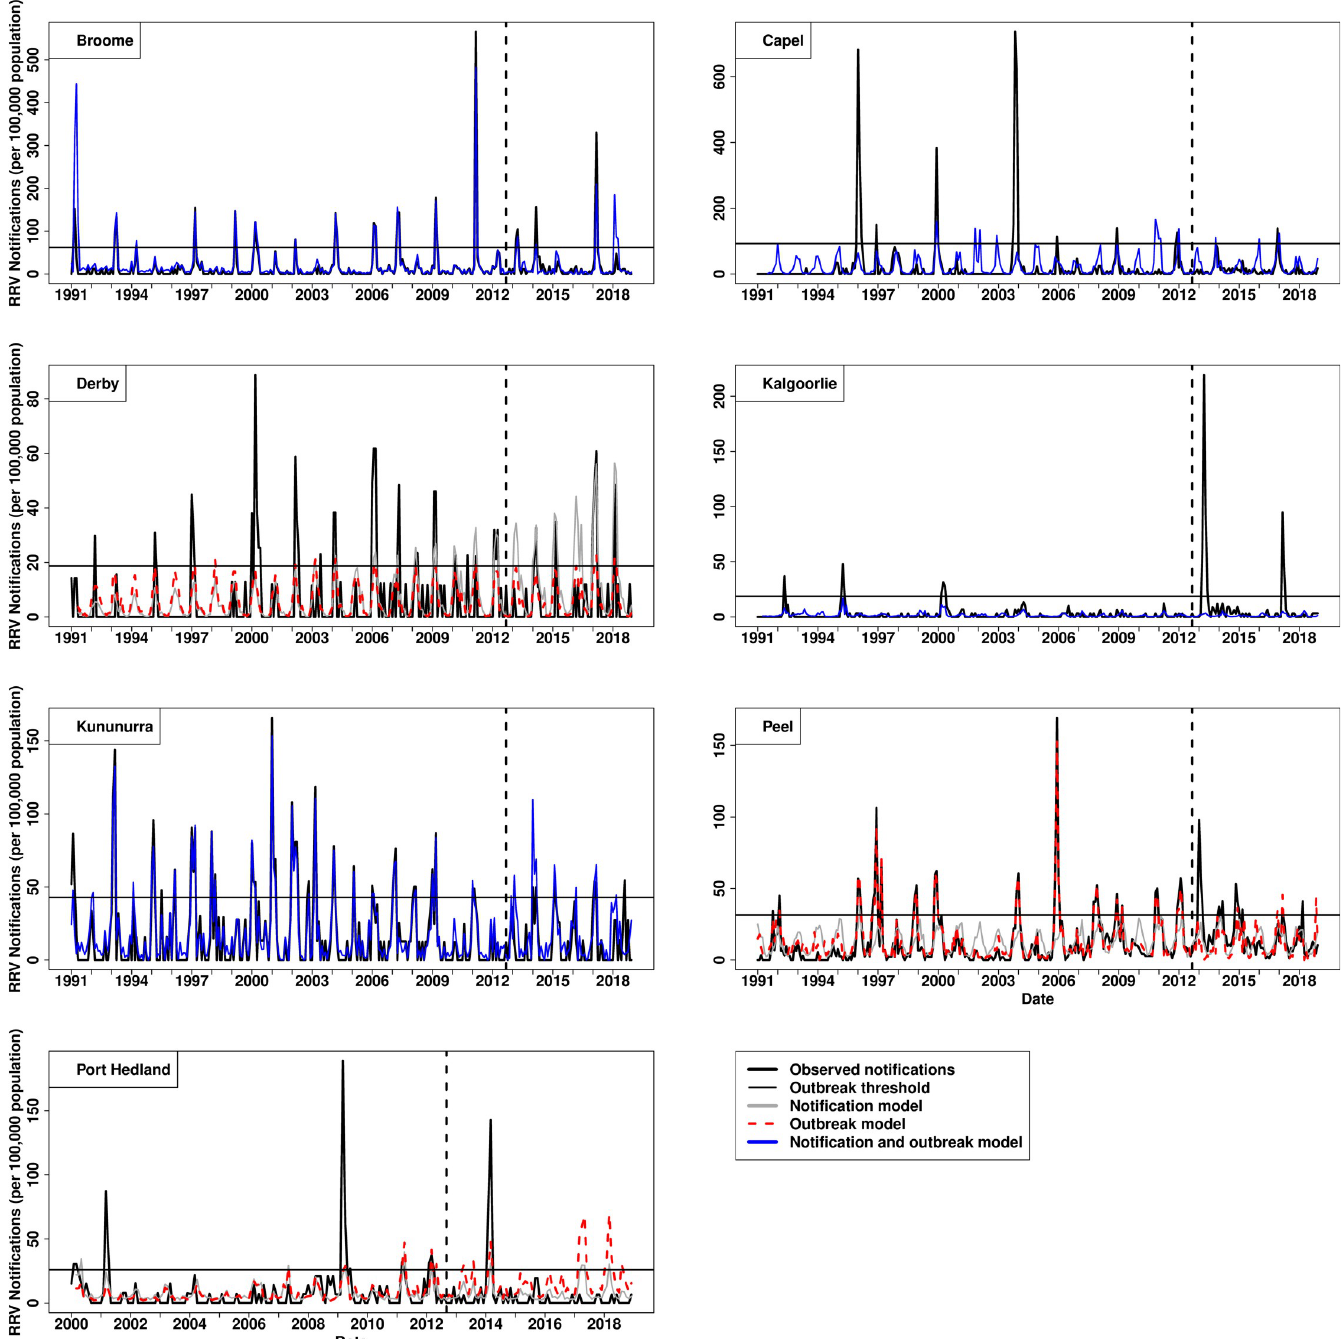
Fig 3. Best fit predictive models of Ross River virus notifications (per 100,000 population) per month for six local government areas in Western Australia. Legend: solid black line: observed RRV notifications, solid grey line: model predicted RRV notifications, dotted red line: model predicted notifications used to predict RRV outbreaks, solid light blue line: model predicted RRV notifications used to predict observed RRV notifications and outbreaks, horizontal solid black line: RRV notifications threshold to classify outbreaks, dash vertical black line: splitting training (left side of line) and testing (right side of line) data.